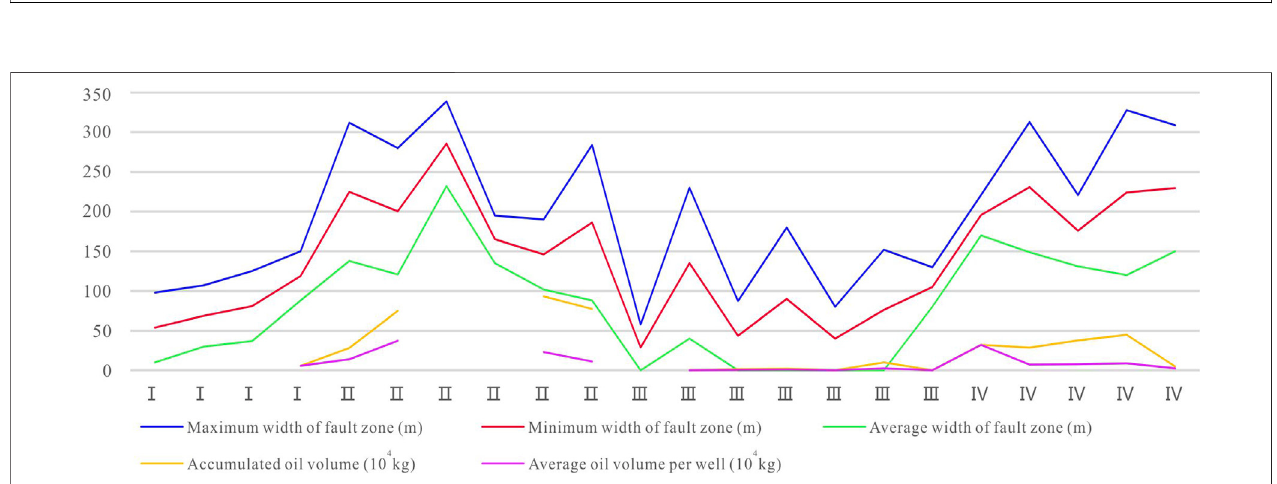
FIGURE 6 | Fault width and oil and gas production of the tp12cx strike slip fault.